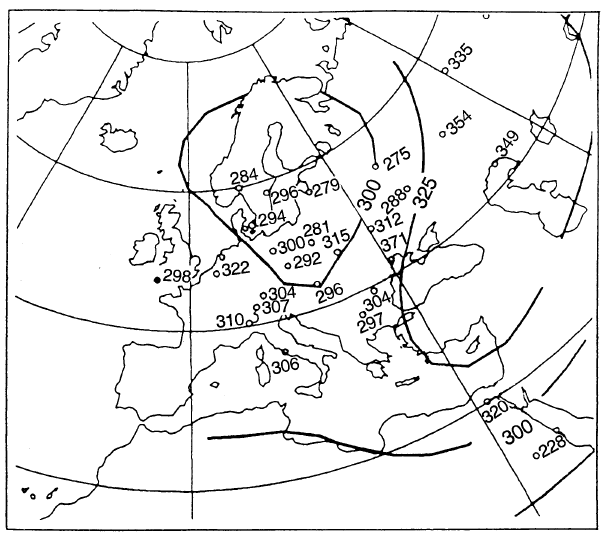
Fig. 1. 24 December 1992; ozone map (Courtesy of LAP Univ. of Thessaloniky, Greece)